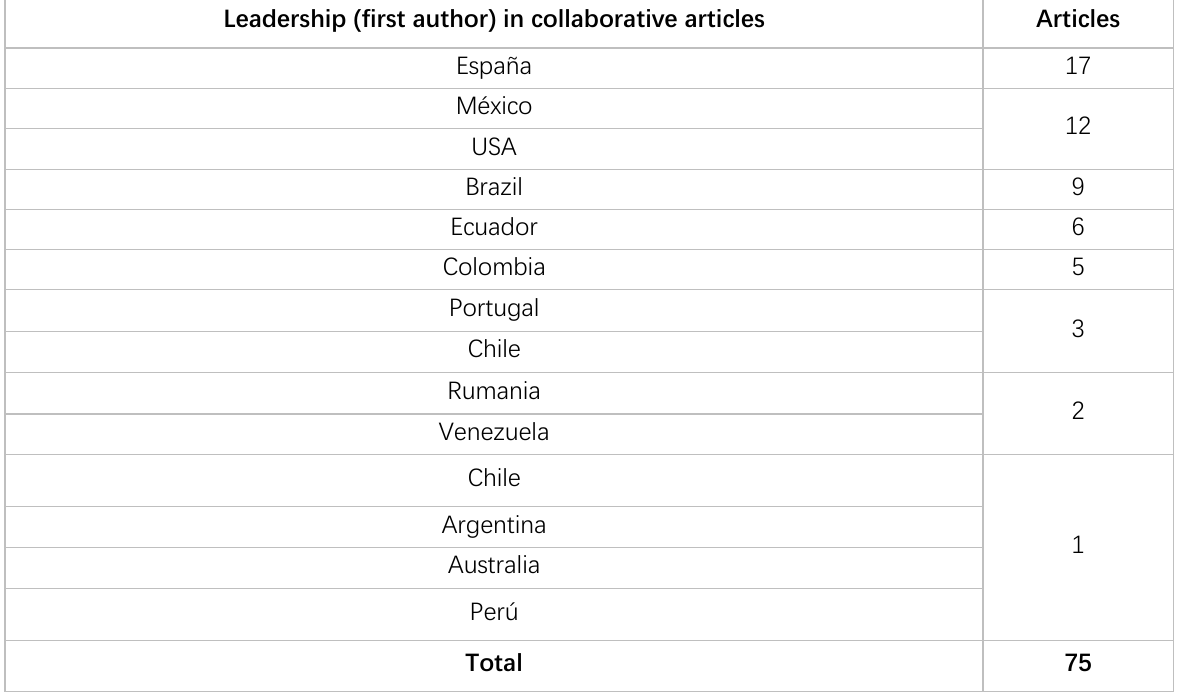
Table 1 . Collaborative articles by country of the first author Leadership (first author) in collaborative